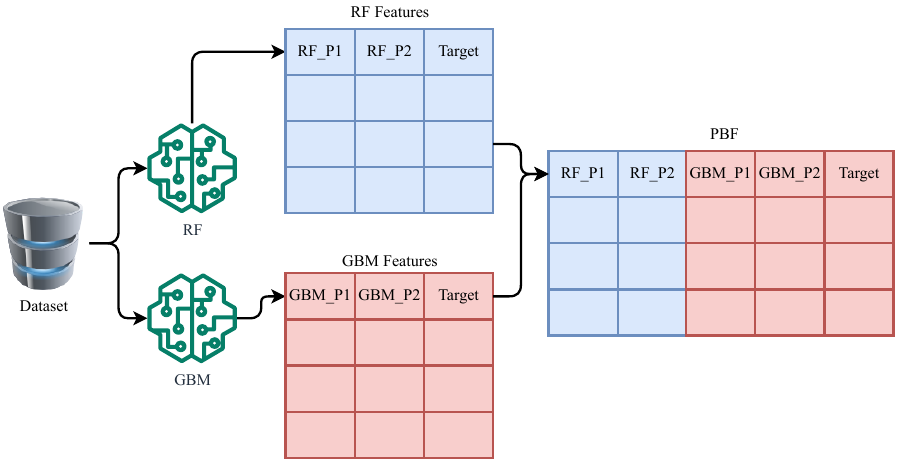
Figure 3. Schematic diagram of the proposed PBF